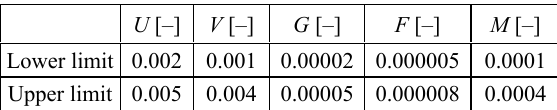
Table 1. The bound set of Pariseau